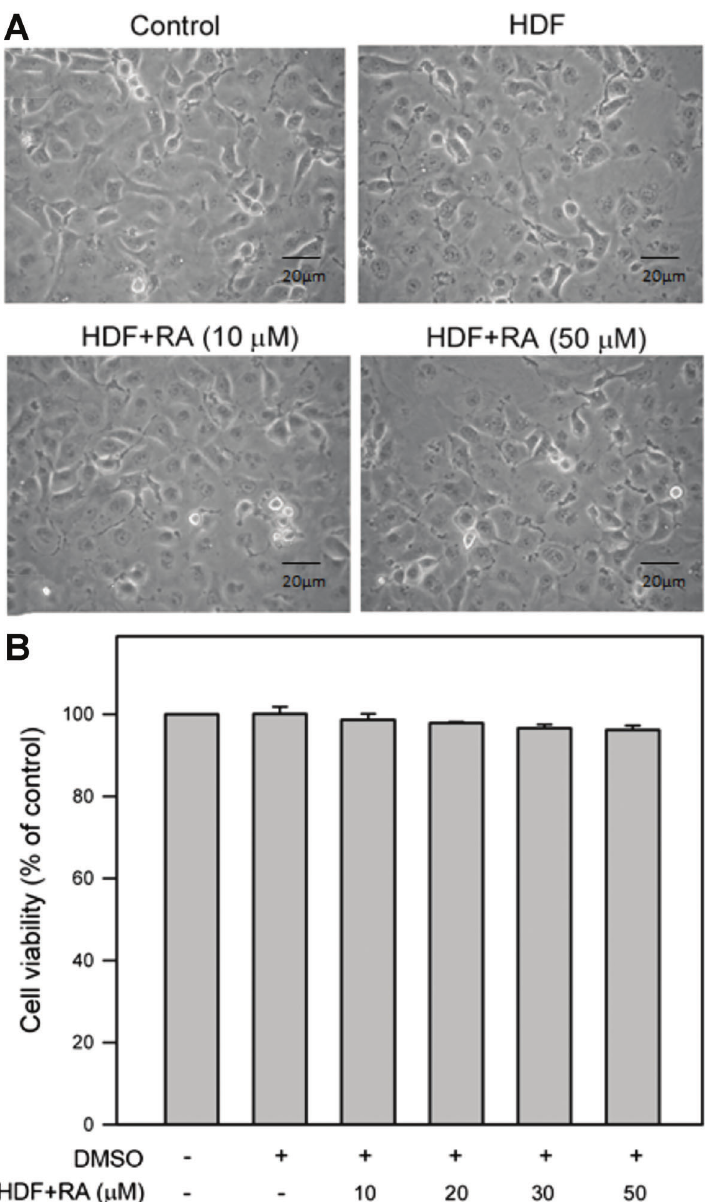
Figure 1. Effects of hemodialysis fl uid (HDF) supplemented with rosmarinic acid (RA) on morphology and viability of human umbilical vein endothelial cells. A , Cells were treated with HDF or HDF supplemented with 10 mM or 50 mM RA for 24 h, and the cell morphology was monitored by phase-contrast microscopy (400 (cid:1) ). B , Cells were treated with DMSO, HDF or HDF supple- mented with serial concentrations of RA for 24 h, and the cell viability was determined by MTTassay. These results revealed that HDF sup- plemented with RA ( p 50 m M) had no signi fi cant in fl uence on morphology and cell viability of